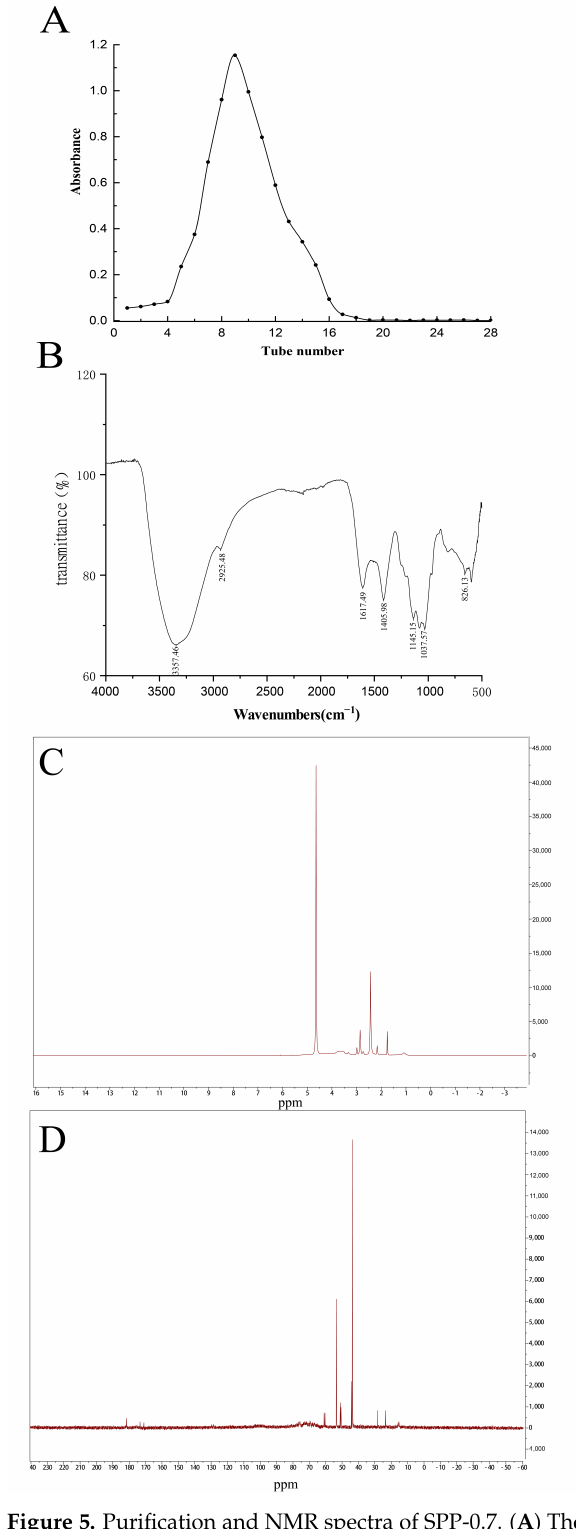
Figure 5. Purification and NMR spectra of SPP-0.7. ( A ) The elution curve of SPP-0.7 on the Sephadex G-100 gel chromatography column, ( B ) FT-IR spectra of SPP-0.7A, ( C ) 1 H-NMR spectrum of SPP-0.7A, and ( D ) 13 C-NMR spectrum of